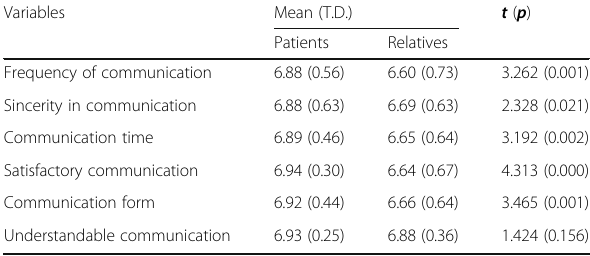
Table 1 (abstract 000866). Differences in quality of communication in the ICU perceived by patients and relatives Variables Mean